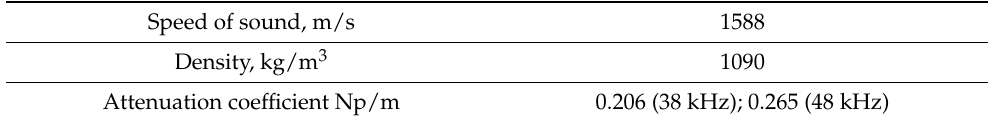
Table 3. Material properties of muscle [22].